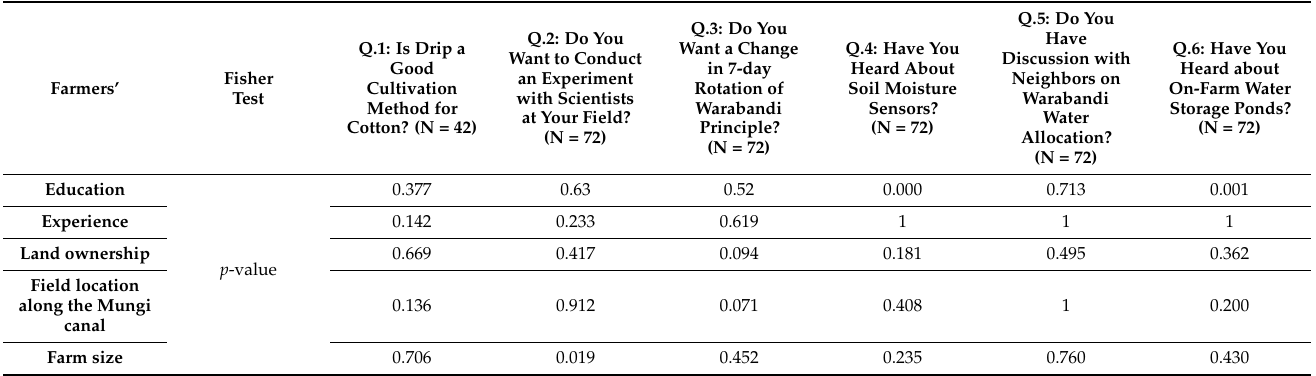
Table 2. Cross-tabulation results for the categorical variables versus independent variables related to